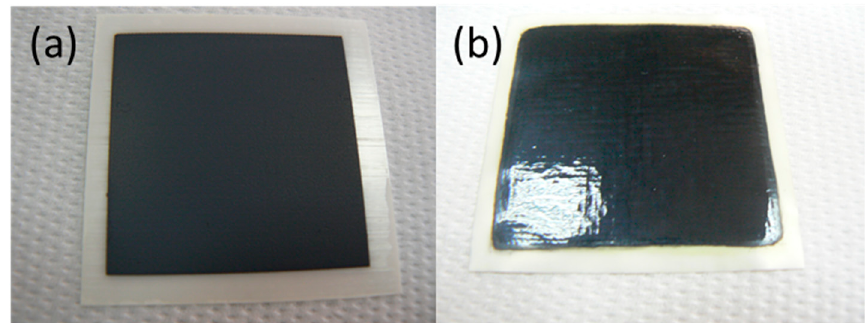
Figure 2. LSCF cathodes inkjet printed ( a ) and infiltrated with Gd-doped ceria (CGO) ( b ) on a large scale (50 × 50 mm) 150 µm thick 3YSZ electrolyte substrate.